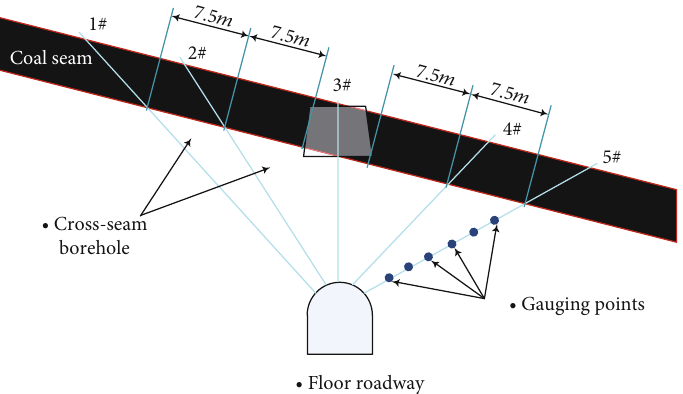
Figure 8: Test scheme.